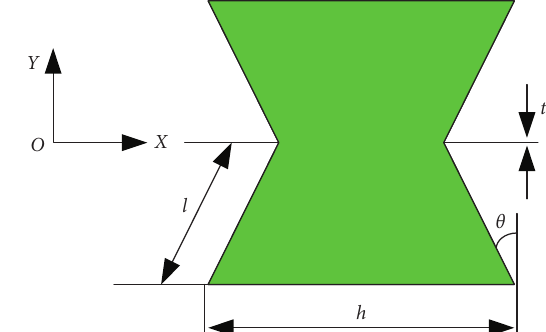
Figure 2: Model of the cell of the auxetic honeycomb core layer.